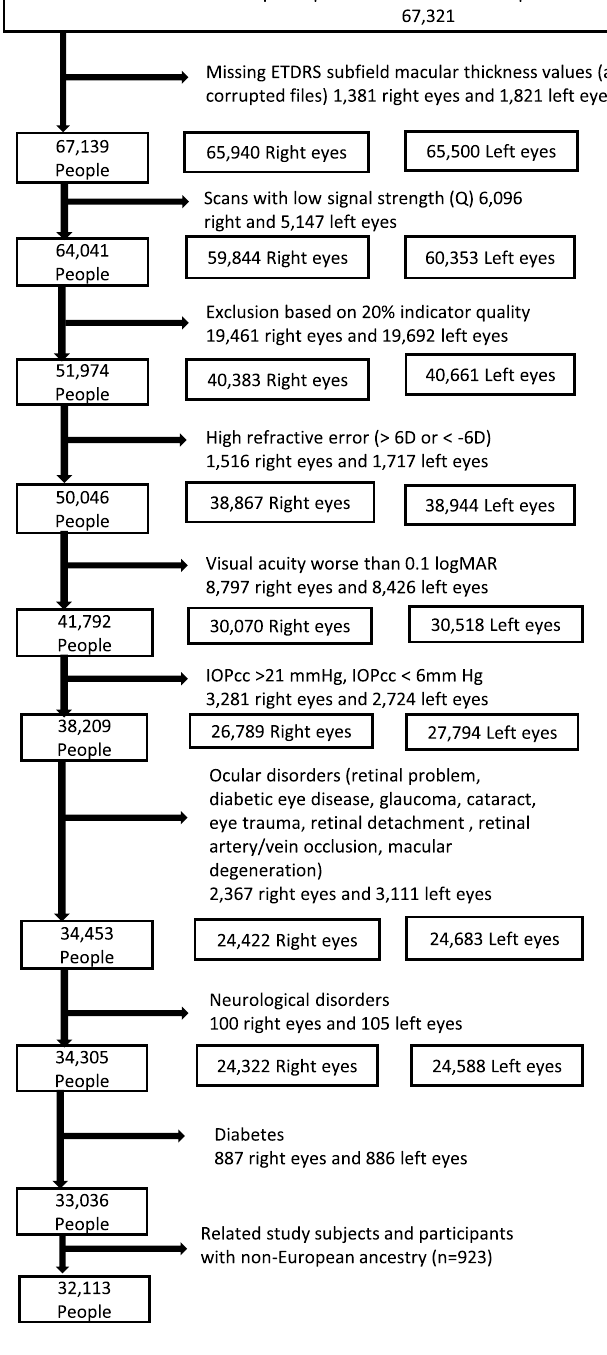
Figure 2. 3D Bar Graph depicting the Inner nuclear layer-External limiting membrane (INL-ELM) (average) layer thickness and the additive effects of NPLOC4-TSPAN10 and CFH risk alleles. Alleles shown are those that confer additional AMD risk. The colour of the bars represents the increasing INL-ELM average layer thickness. Homozygosity for NPLOC4-TSPAN10 AMD-risk SNP (TT) rs6565597 and CFH protective SNP rs10922109 (AA) alleles revealed a significantly thinner INL-ELM. Absence of NPLOC4-TSPAN10 risk SNPs in the presence of homozygosity for the CFH protective SNP resulted in a significantly thickened INL-ELM. Homozygosity for NPLOC4-TSPAN10 AMD-risk SNP (TT) rs6565597 and CFH risk SNP rs10922109 (CC) alleles revealed a significantly thicker INL-ELM (p = 0.0004; adjusted p-value =